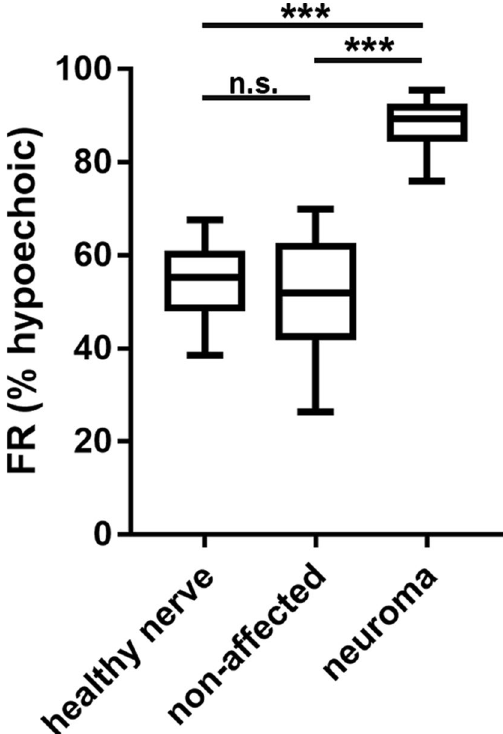
Figure 4. The FR is significantly increased in neuromas compared to the patients’ non-affected nerve portions as well as to the volunteers’ healthy control nerves. 1-way ANOVA with Tukey multiple comparison test.